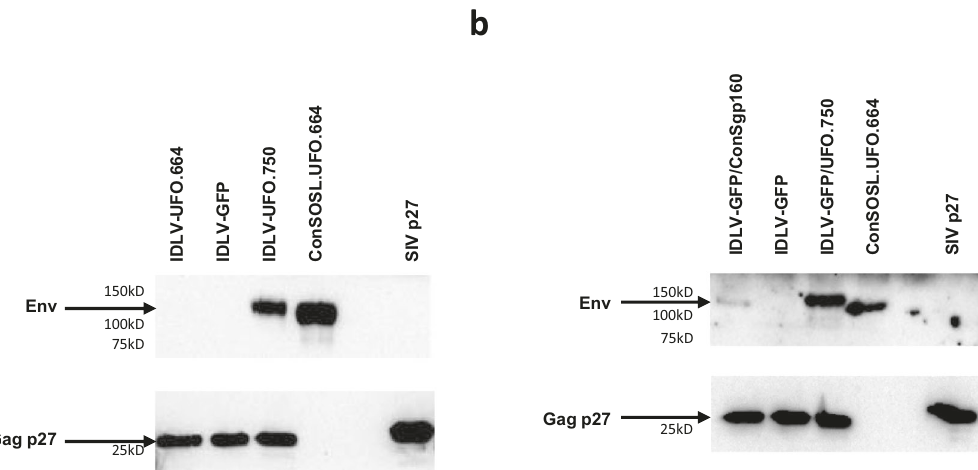
Fig. 3 Incorporation of ConSOSL.UFO.750 envelope on IDLV particles. Western blot of lysates from concentrated preparation of a IDLV- UFO.664 and IDLV-UFO.750 and b IDLV-GFP pseudotyped either with parental ConSgp160 or native-like ConSOSL.UFO.750 envelopes. Recombinant ConSOSL.UFO.664 and p27 SIVGag proteins (1 µg each) and IDLV-GFP were used as controls. Filters were probed with anti-Env 2G12 or anti-SIV p27 Abs. All blots derive from the same experiment and were processed in parallel. Shown are results from one representative of n = 3